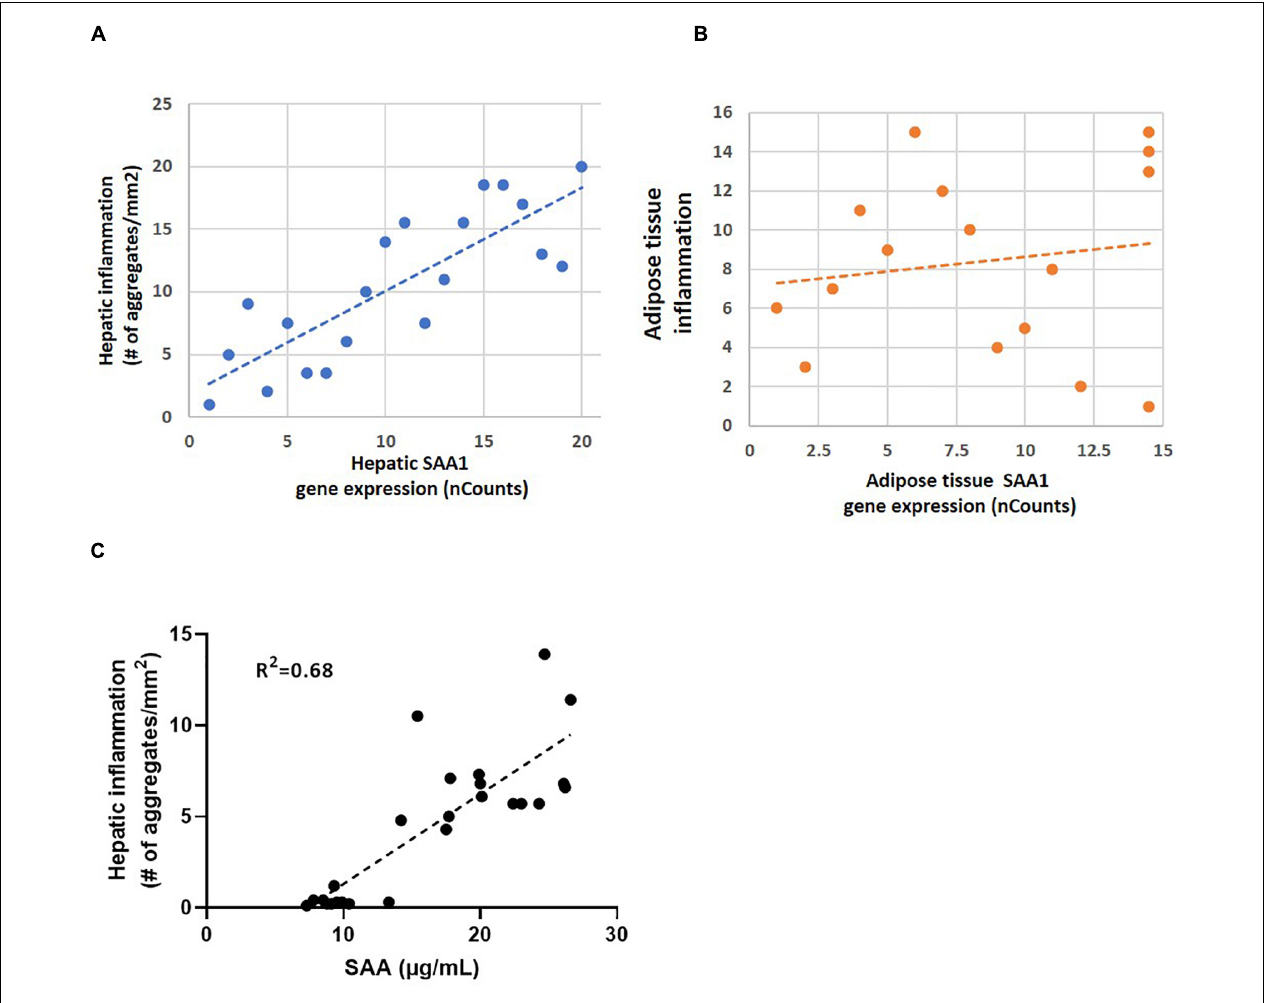
FIGURE 4 | (A) Correlation analysis of hepatic inflammation based on immuno-histochemical staining of inflammatory aggregates in liver and hepatic SAA1 expression in mice ( R 2 = 0.82; P < 0.01); (B) Correlation analysis of adipose tissue inflammation based on immuno-histochemical staining of crown-like structures and adipose tissue SAA1 expression in mice ( R 2 = 0.15; P > 0.5); (C) Correlation analysis of hepatic inflammation in liver and plasma SAA1 levels ( R 2 = 0.68; P <